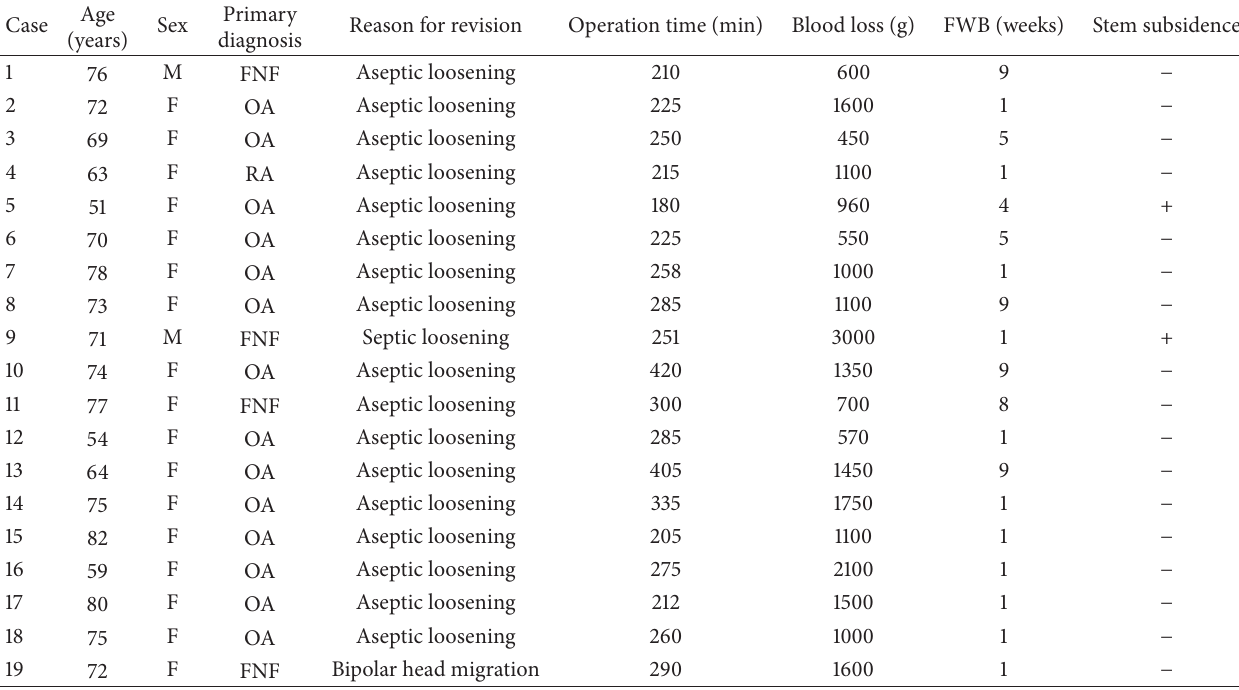
Table 1: The patients demographic and operative